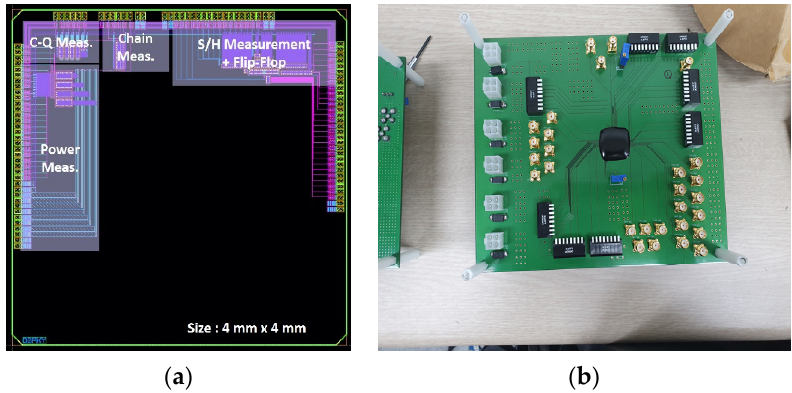
Figure 12. ( a ) Chip Layout; ( b ) Testing PCB with a Fabricated Chip.